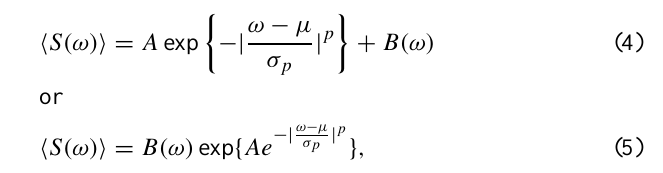
Fig. 1. Two-way antenna beam patterns ∝ G( ˆ r)A( ˆ r) used in (a) May 2004 and (b) in July 2004 experiments. The patterns are shown in dB with a common normalization and vary with direction cosines θ x ≡ sin θ cos φ and θ y ≡ sin θ sin φ , where θ is measured from the Jicamarca on-axis position and φ is azimuth angle measured from SE towards NE. True zenith is in θ x =0 and θ y =0.04 direction, the direction of peak response in the left panel in (b).